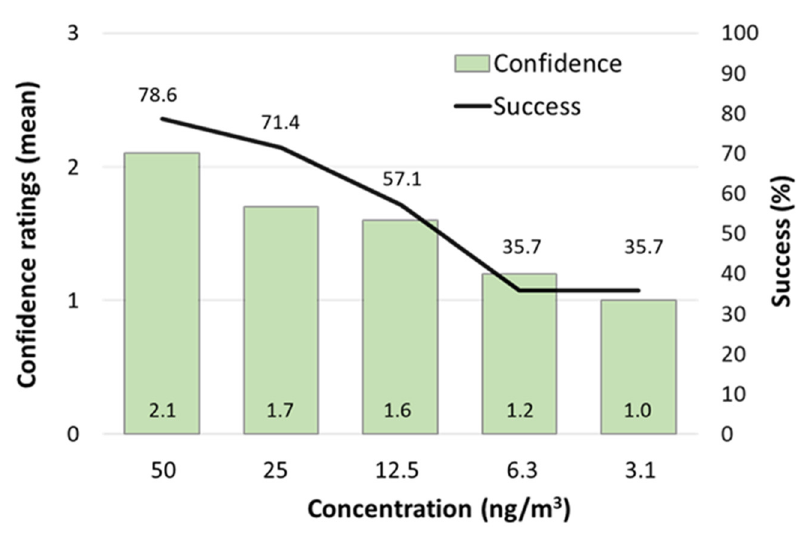
Figure 2. Odor detection of 2,4,6-trichloroanisole (3CA) among 14 healthy volunteers. The solid line connects the percentage of subjects that identified 3CA at di ff erent concentrations. The bars show the mean level of confidence among the subjects that identified 3CA (coding 0–3, as follows: 0 = “random”, 1 = ”followed a feeling”, 2 = ”not sure”, 3 =